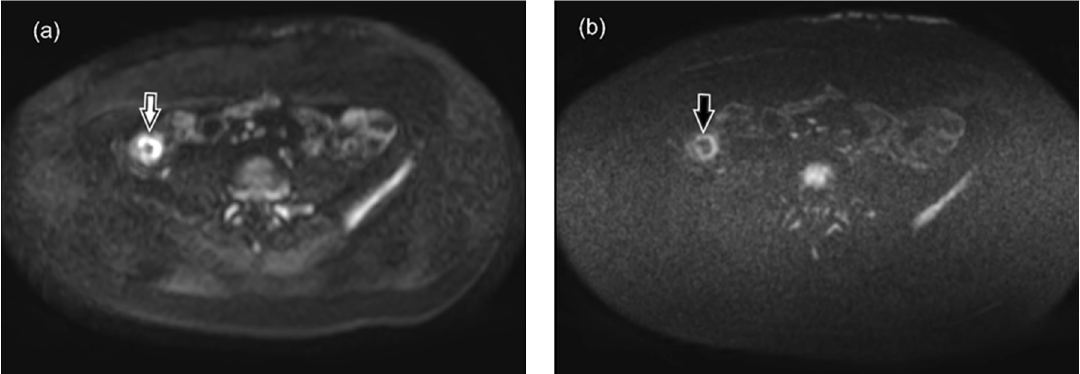
Figure 8. DWI SPIR ( a ) and DWI STIR ( b ) tracking images of b = 800 s / mm 2 images of 40 years old male patient with active CD. Inflamed bowel walls present high signal intensity. Despite decreased SNR causing graininess in the images, the resolution of inflamed bowel and delineation of contours is better in DWI STIR image (black arrow) as compared to the DWI SPIR image (white arrow).